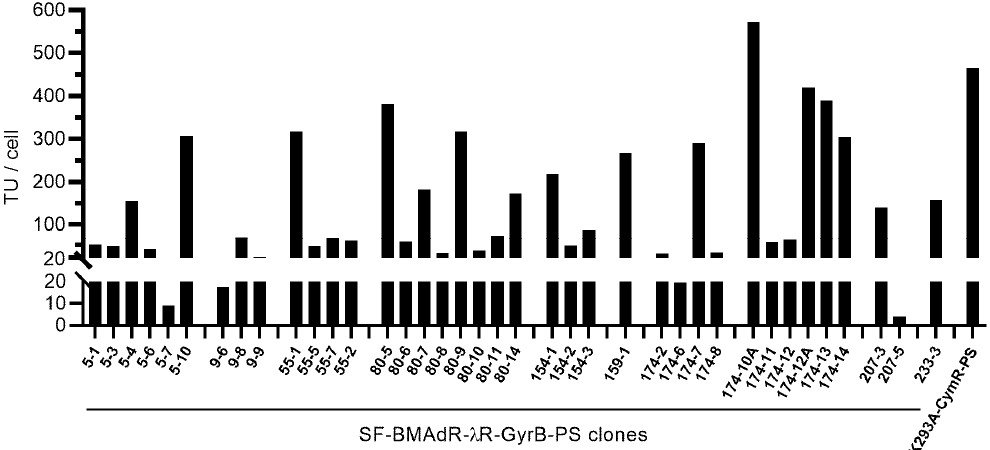
Figure 3. Production of AdPS-/CU by SF-BMAdR- λ R-GyrB-PS subclones. Cells were infected using a MOI of 5 transduction unit(s) (TU)/cell in the presence of 5 nM of coumermycin. The specific productivities of infectious vector particles (TU/cell) were determined by flow cytometry ( n = 1). The HEK293A-CymR-PS cell line was infected in the same manner in the presence of 50 µg/mL of cumate and used as a comparison.